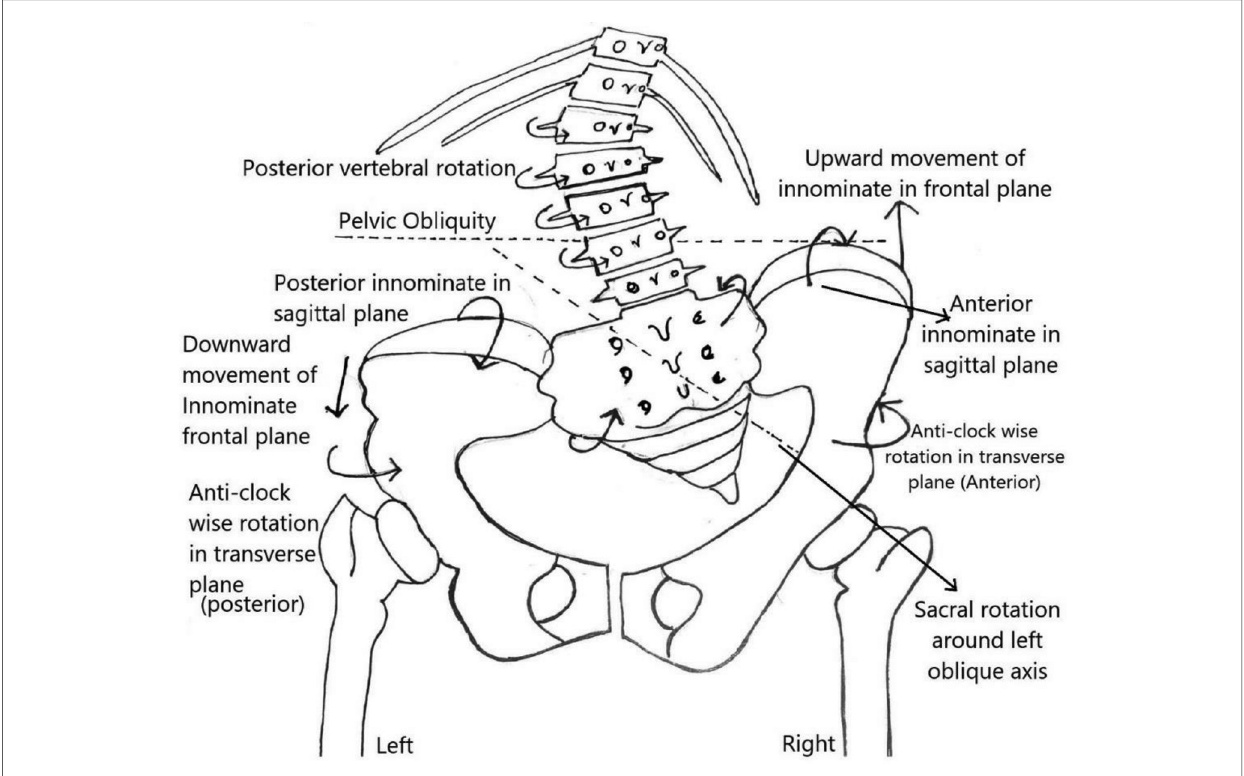
FIGURE 1 Directional Components of Pelvic obliquity as observed in a PA radiograph of left lumbar curve showing three dimensional motion of innominates and sacral